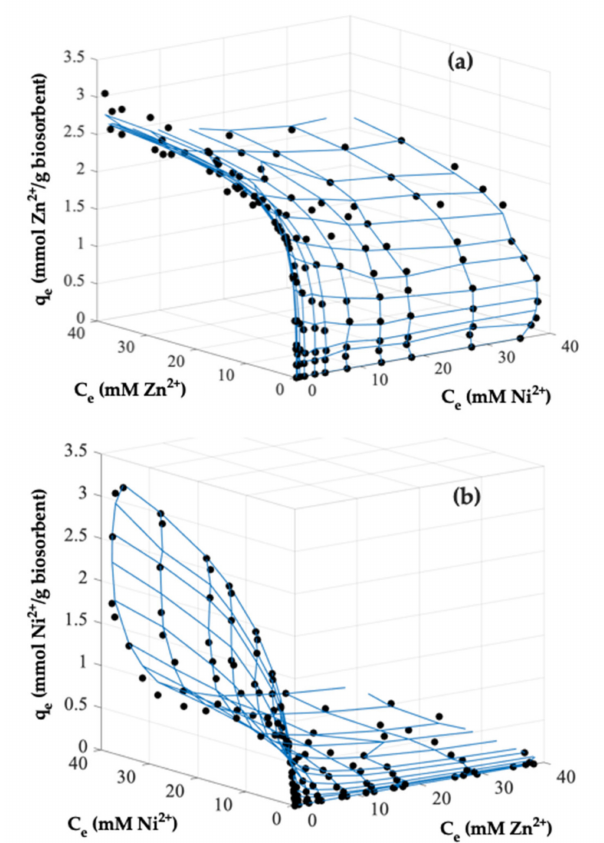
Figure 4. Binary biosorption isotherms of Zn 2+ and Ni 2+ on CS. ( a ) The effect of Ni 2+ on the equilibrium biosorption of Zn 2+ and ( b ) the effect of Zn 2+ on the equilibrium biosorption of Ni 2+ . The 3D surfaces represent predictions from the modified Sips model, while the black circles represent the experimental